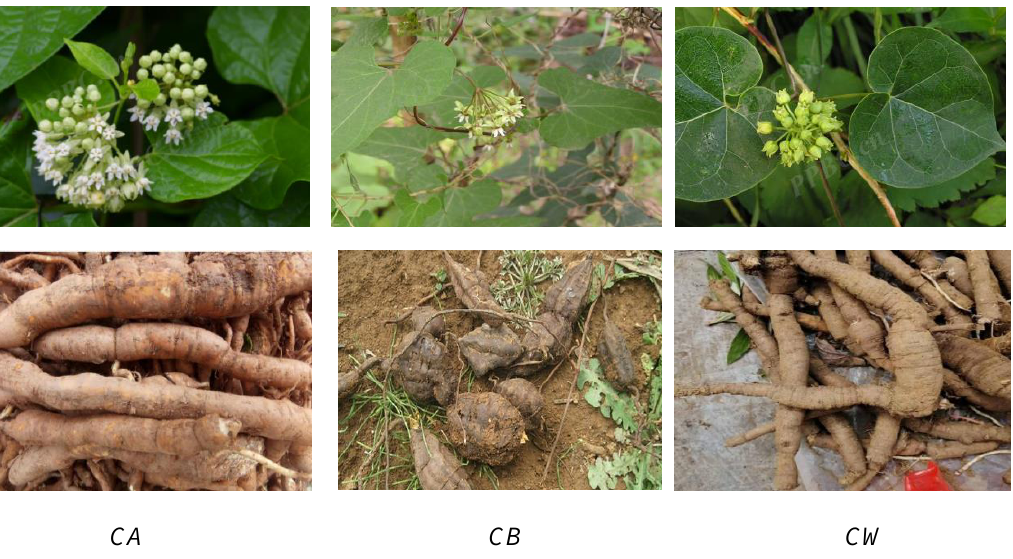
Figure 1. Morphological characteristics of CA , CB and CW.